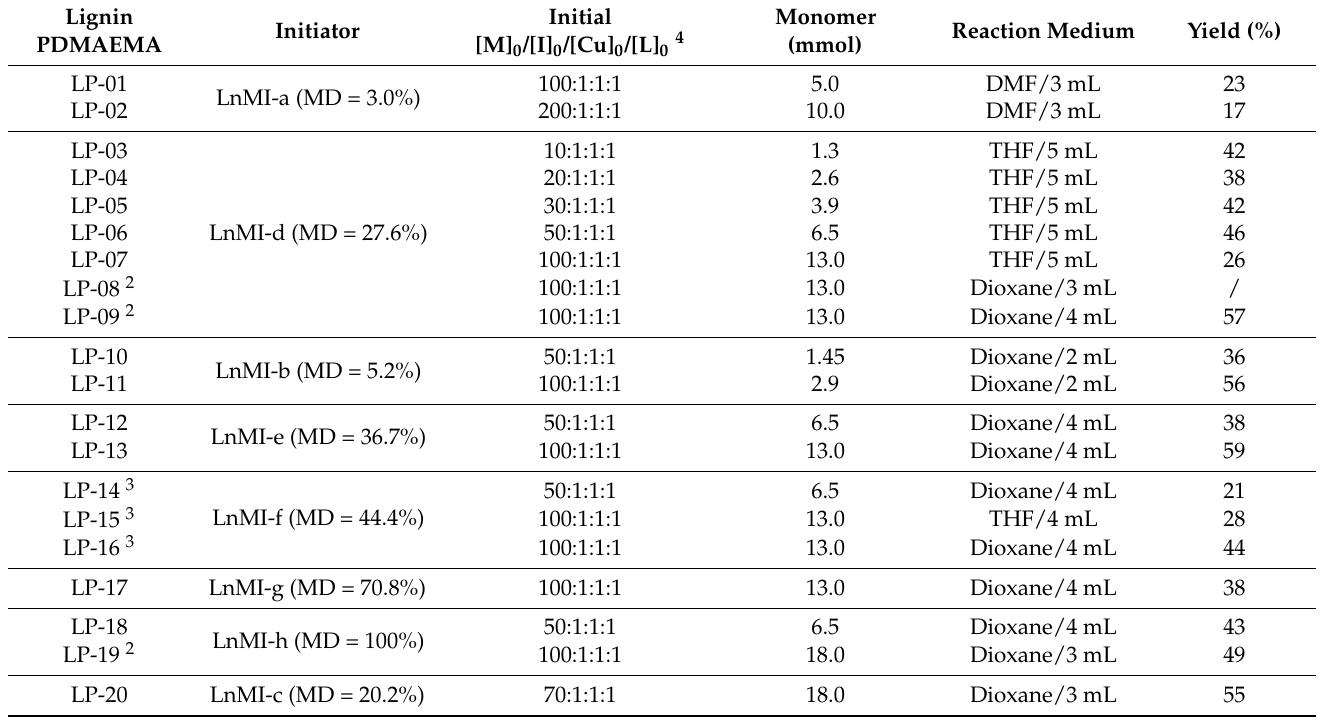
Table 3. The selected polymerization conditions for lignin-PDMAEMA copolymers 1